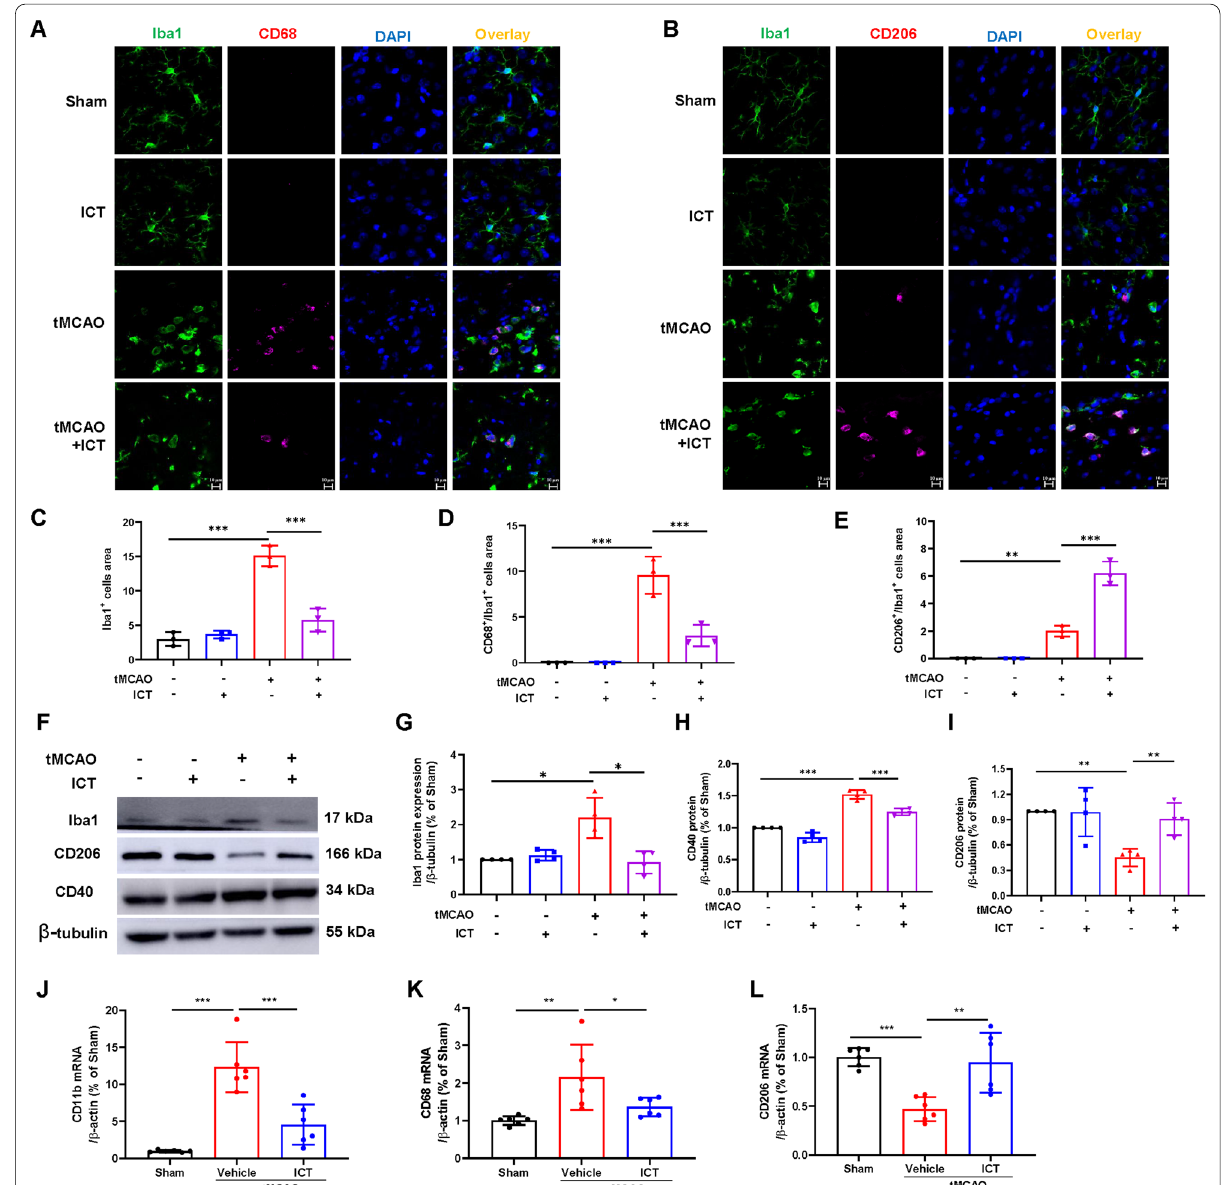
Fig. 3 The effect of ICT on activation and polarization of microglia in tMCAO rats. A and B Representative immunofluorescent images of microglia polarization in the ischemic penumbra. The immunofluorescence staining of microglia with anti-CD68 (magenta), CD206 (magenta), and Iba1 (green) antibody. The nucleus was stained by DAPI; scale bar 10 μm. C – E Immunofluorescence quantitation (n 3). F – I The protein expressions of = = Iba1, CD40 and CD206 (n 4). J – L The mRNA expression of CD11b, CD68, and CD206 (n 6). The results are expressed as the mean SD, * P < 0.05, = = ± ** P < 0.01, *** P <